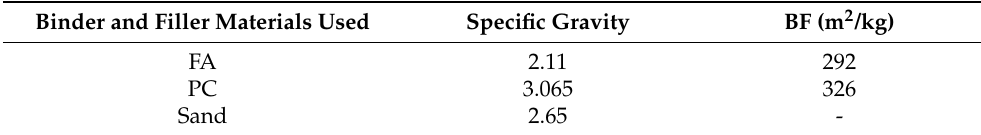
Table 2. Physical properties of binder and filler materials.